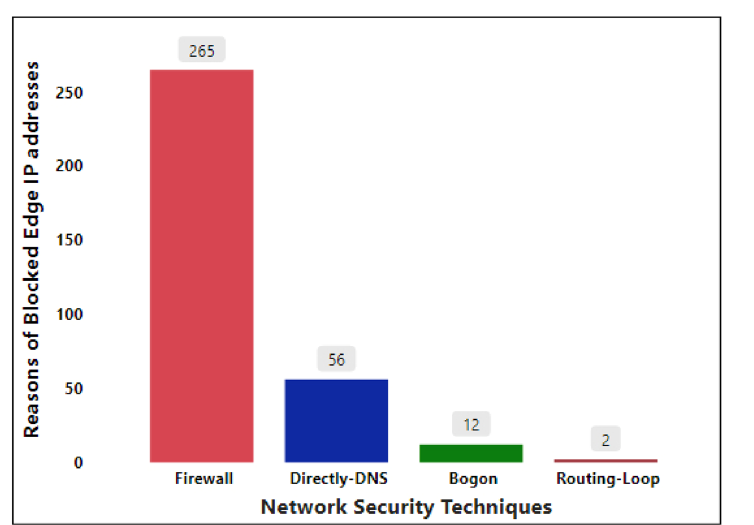
Figure 6. Classification of ASs that are not vulnerable through